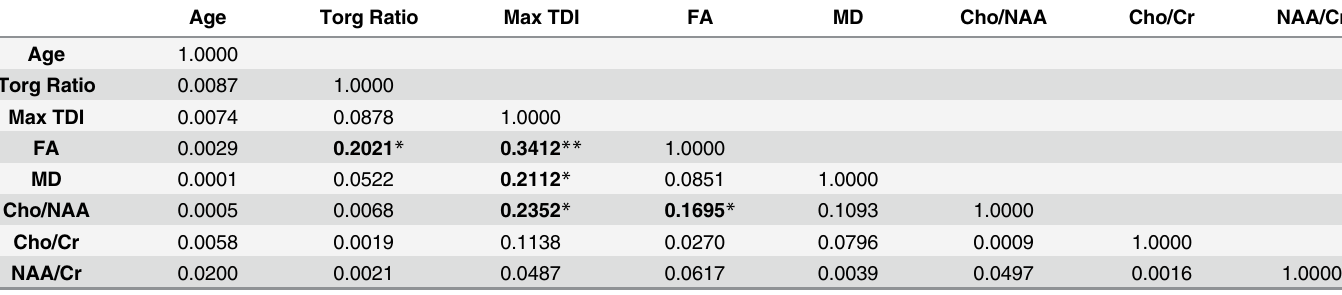
Table 3. Correlation (R 2 ) Between Anatomic, Diffusion, and Spectroscopic MR Measurements.